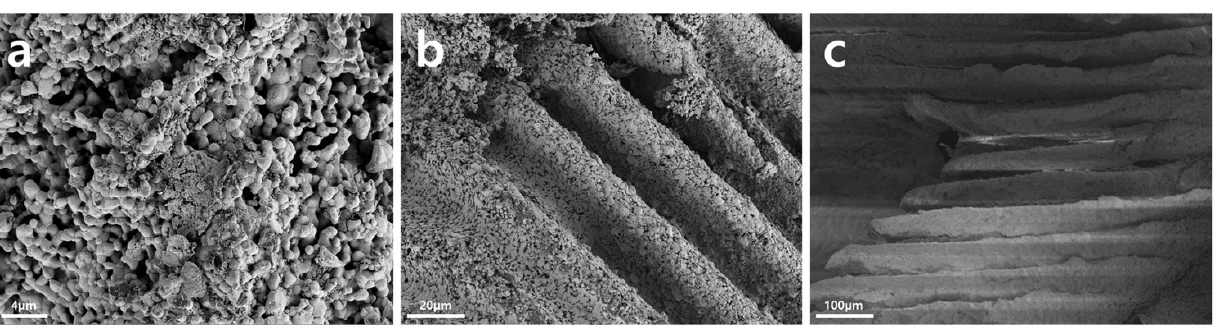
Figure 1. The architecture of 3D-printed HA/TCP scaffolds (SEM): ( a ) ×2000; ( b ) ×500; ( c ) ×100.